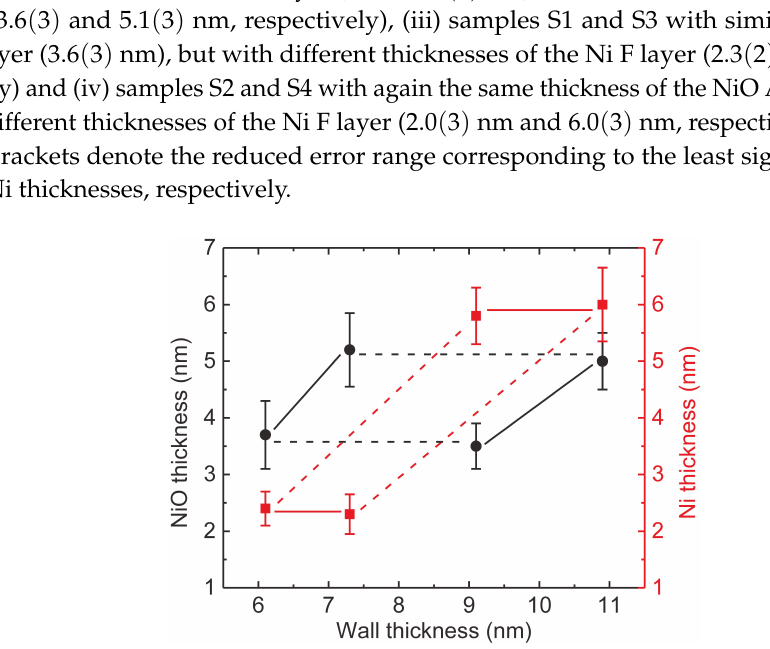
Figure 9. Thicknesses of the NiO layers (black dots) and Ni layers (red squares), as calculated from the differences in the saturation magnetization within the measured hysteresis loops. The solid lines show the cases when the H ex increases with antiferromagnetic (AF) layer thickness, while the dashed lines highlight the situation when H ex decreases with ferromagnetic (F) layer thickness. The overall wall thickness increases from S1 to